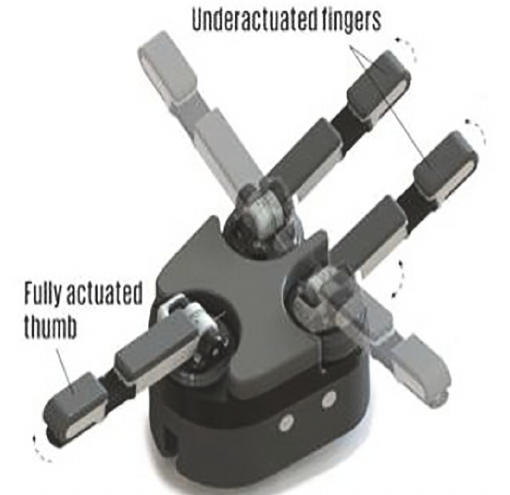
Figure 2: iHY hand design [4].